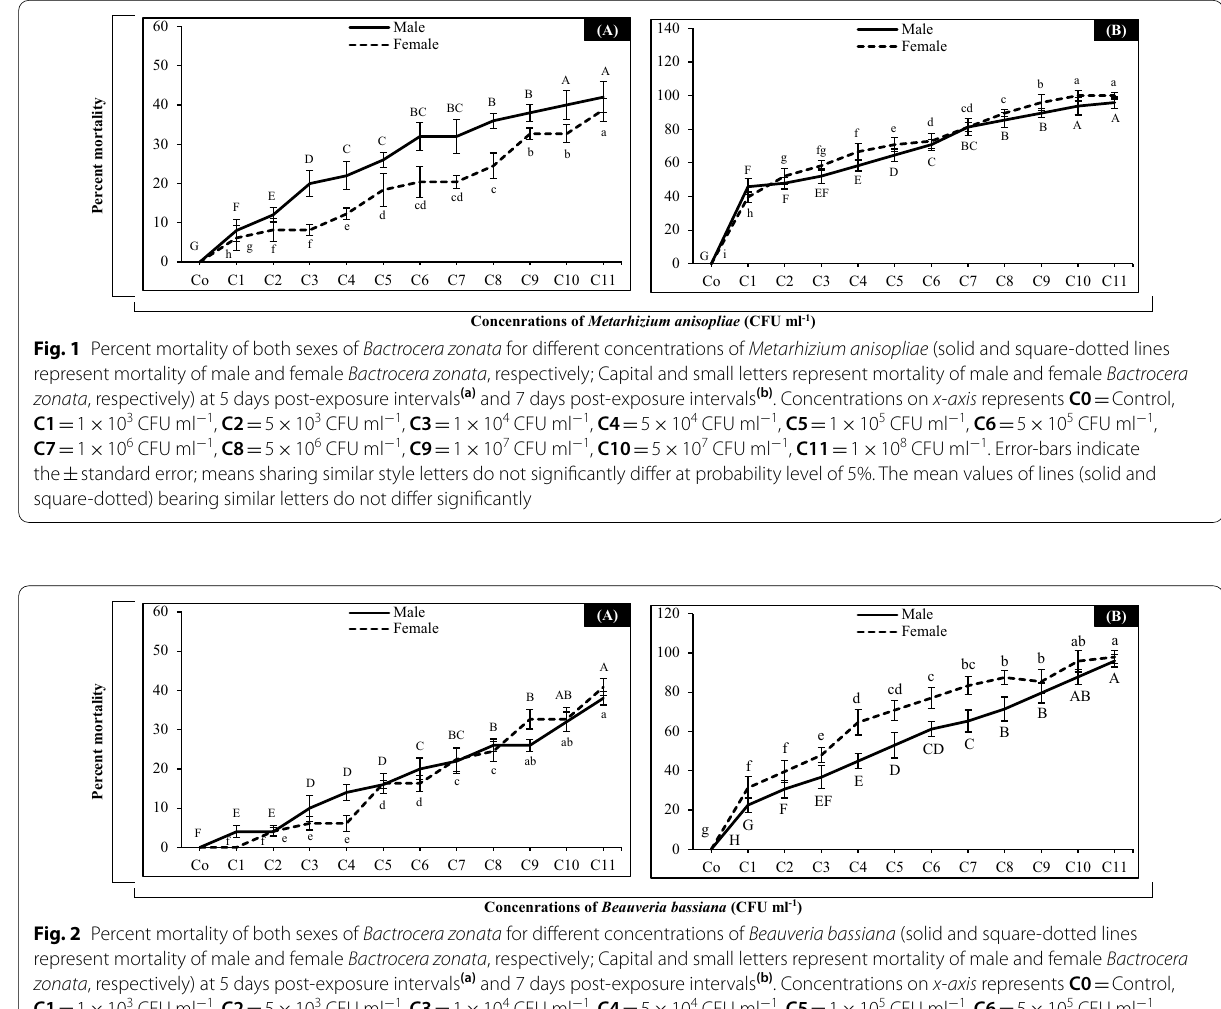
5 10 3 CFU ml − 1 , C3 = × 5 10 6 CFU ml − 1 , C9 = ×